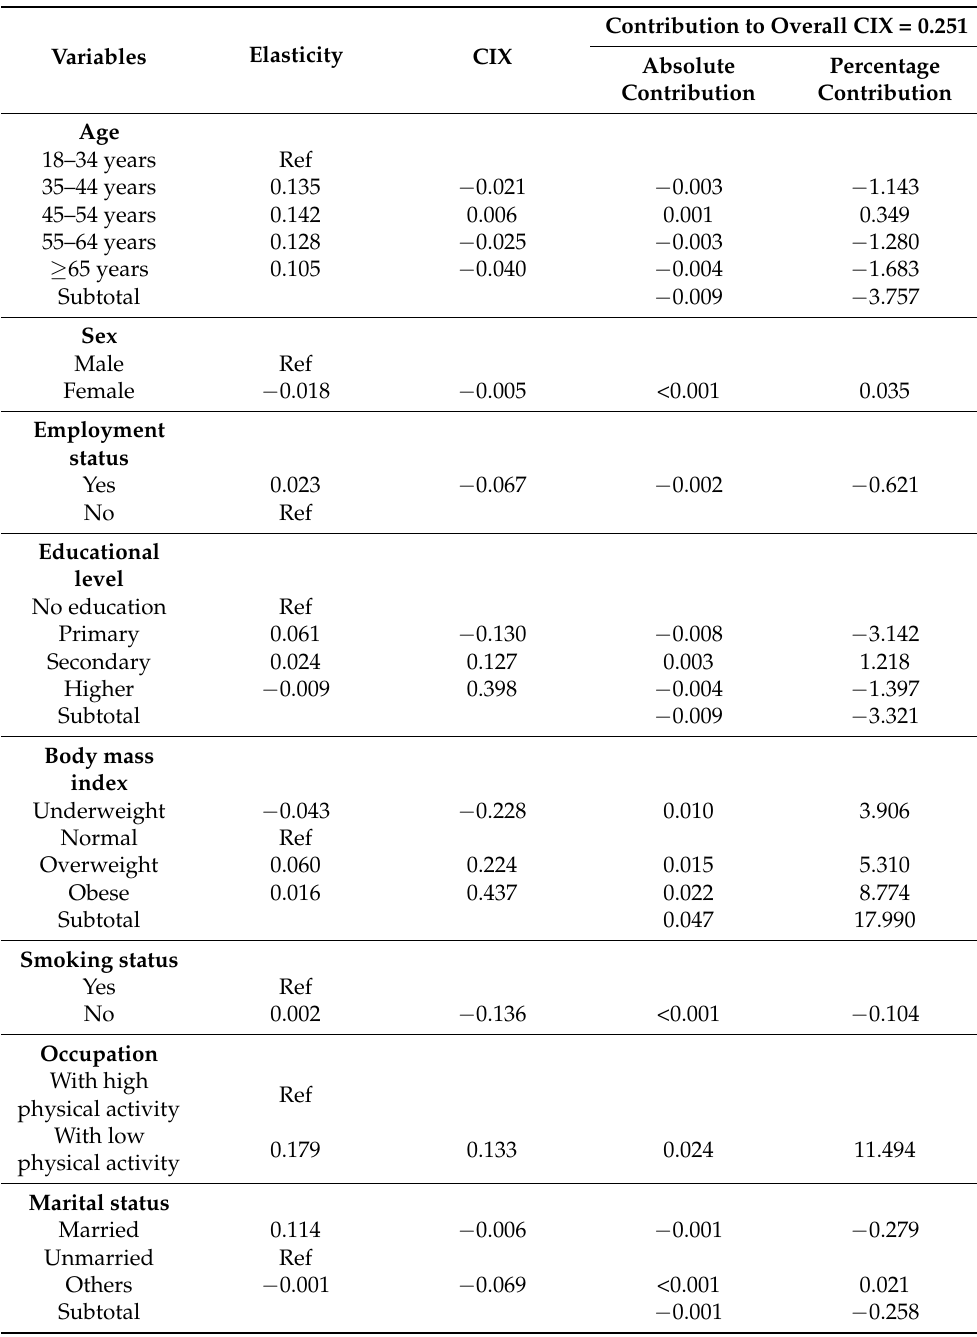
Table 4. Decomposition of inequality measurement of diabetes.